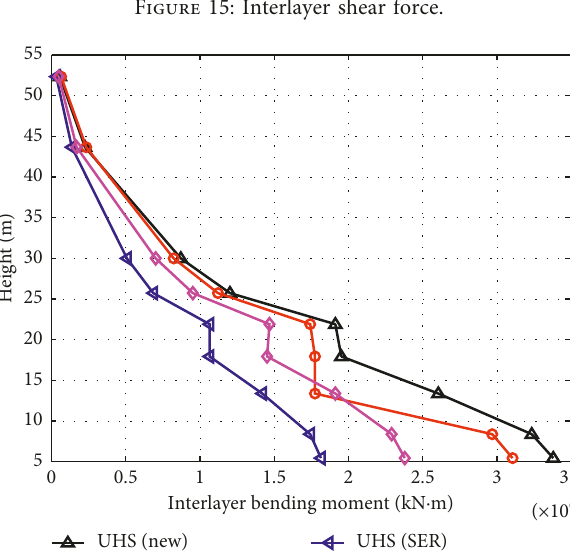
Figure 15: Interlayer shear force.